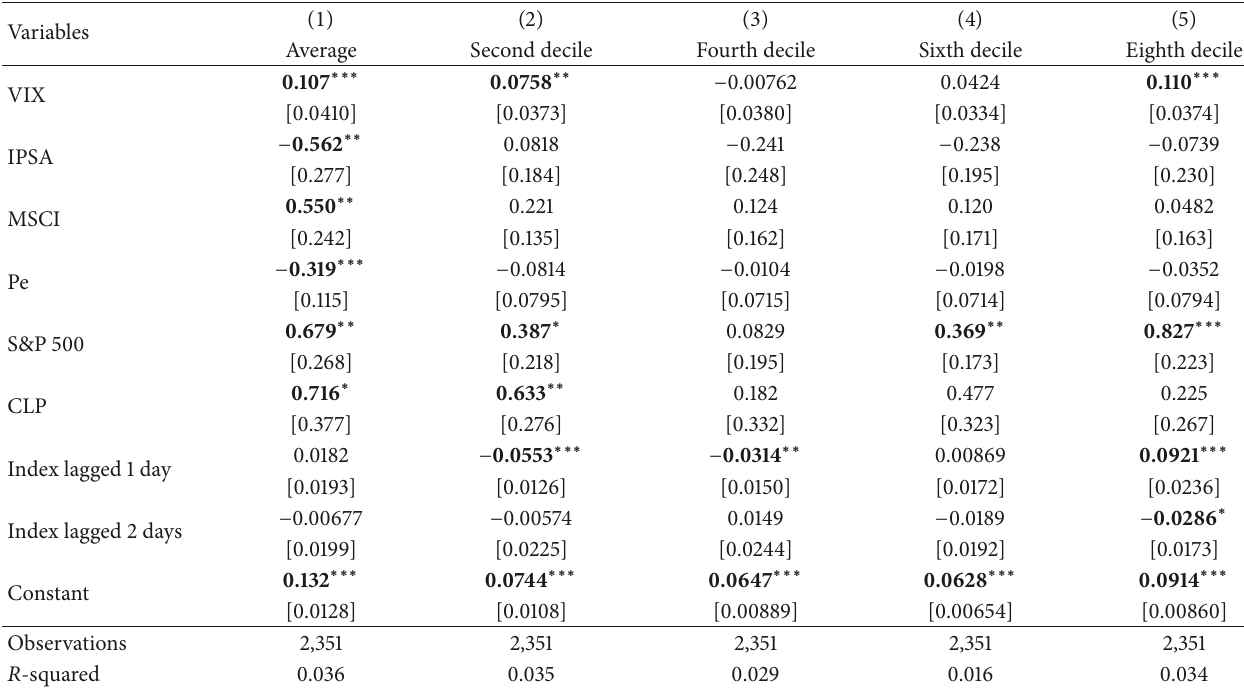
Table 4: Basic model controlling for autocorrelation. This table summarizes the results of the following model: 𝑦 𝑡 = 𝛼 + 𝛽 ∗ 𝑋 𝑡 + 𝛾 1 ∗ 𝑦 𝑡−1 + 𝛾 ∗ 𝑦 + 𝑚 + 𝑁 + 𝜀 2 𝑡−2 𝑡 𝑡 𝑡 . The dependent variable is the proposed index of network change for different thresholds that define a link. We add to the basic model the index lagged in one and two days to study possible autocorrelation. 𝑋 𝑡 corresponds to the returns or growth rate of variables such as IPSA, VIX, Pe, CLP, S&P 500, and MSCI. 𝑚 𝑡 and 𝑁 𝑡 are month and year fixed effects to control for seasonality and variation associated with any specific year. Column (1) uses the average transaction as a threshold. Columns (2) to (5) use the second, fourth, sixth, and eighth deciles as